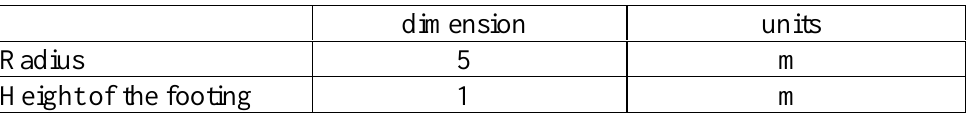
Table 3. Dimensions for the ring